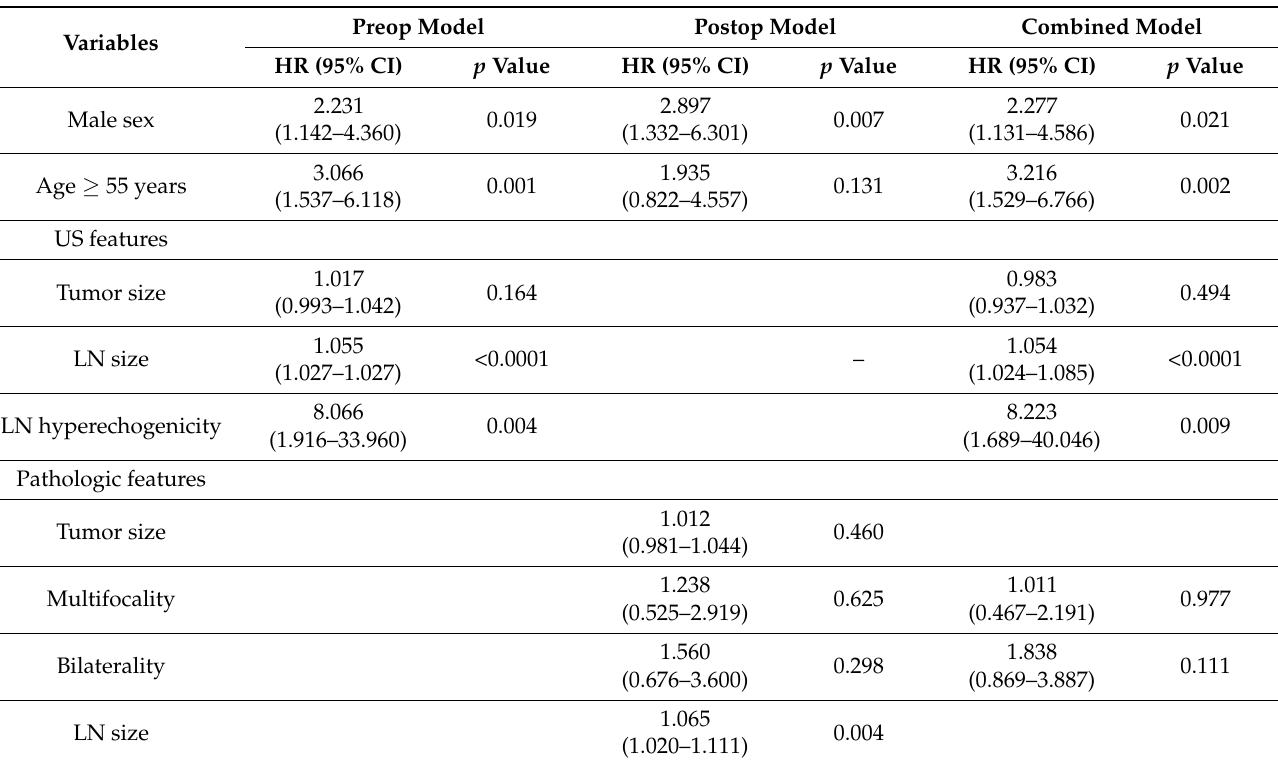
Table 4. Multivariate Cox proportional hazard analysis for predicting recurrence in patients